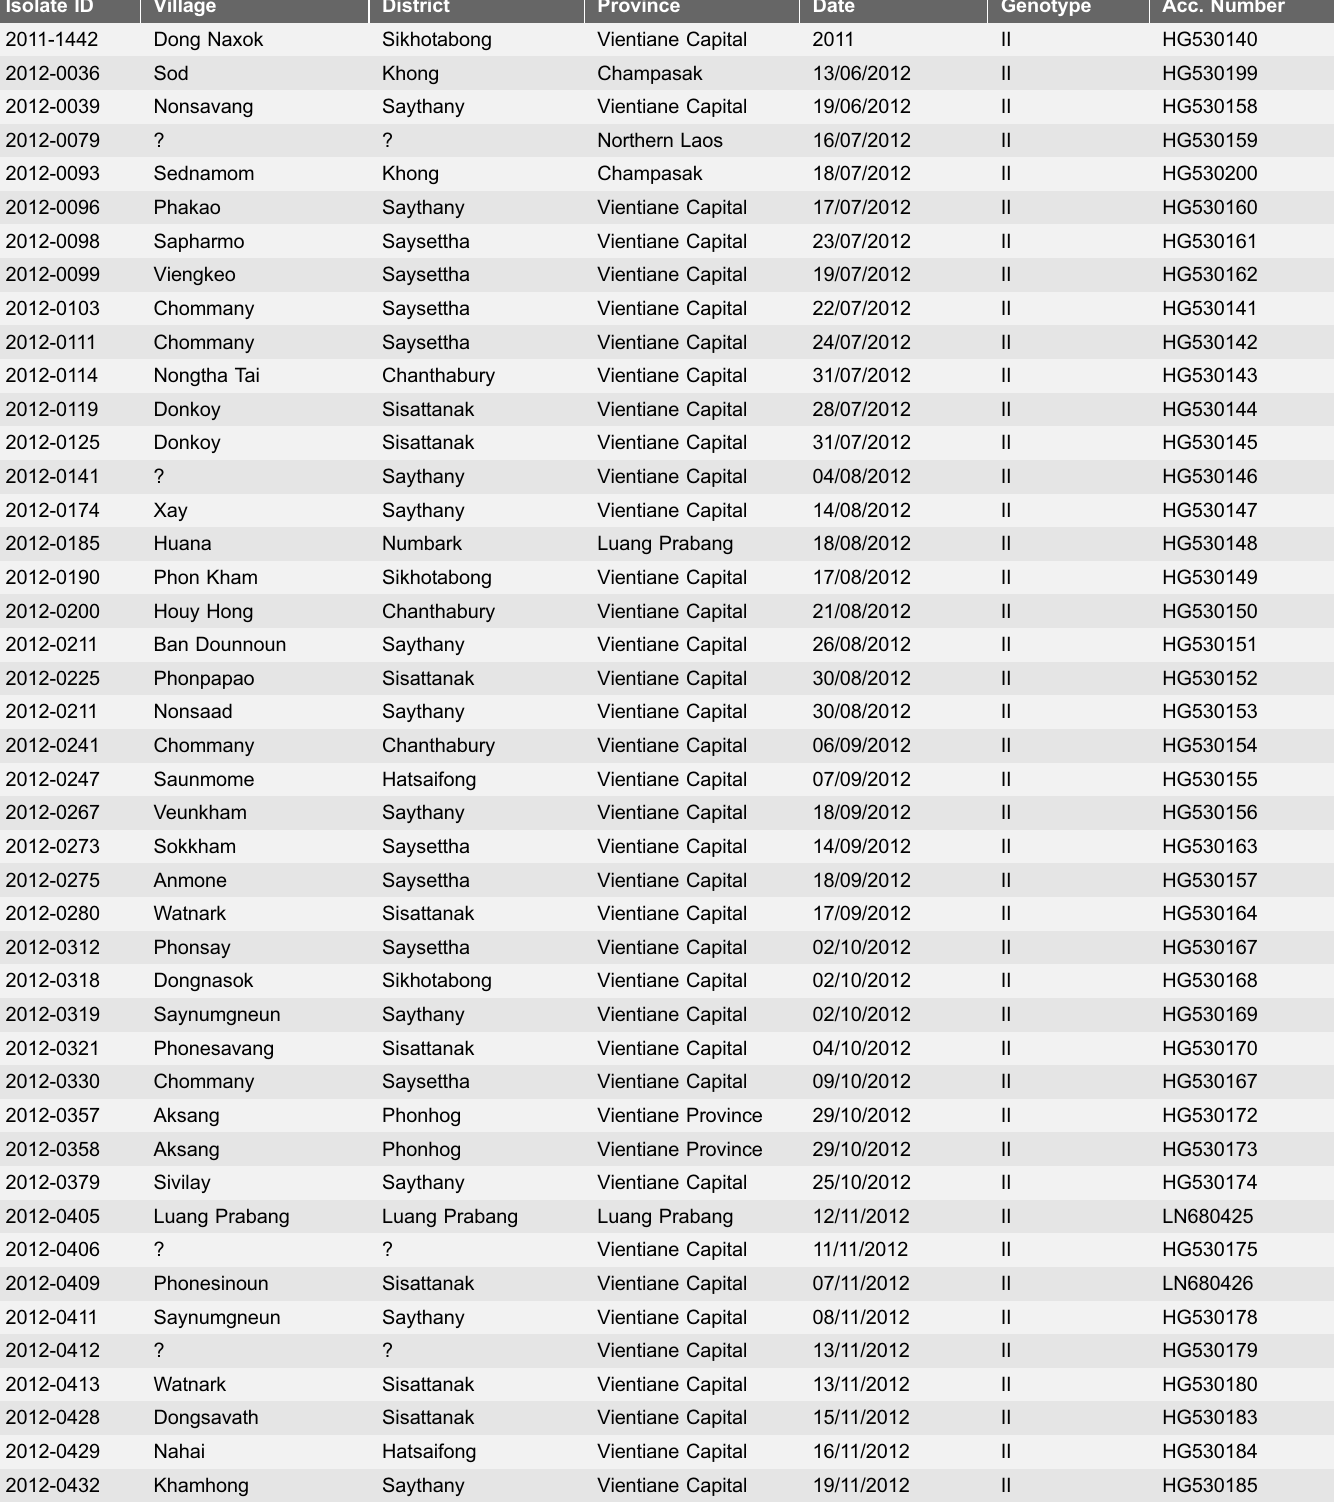
Table 1. List of studied Lao DENV-3 isolates. Isolate